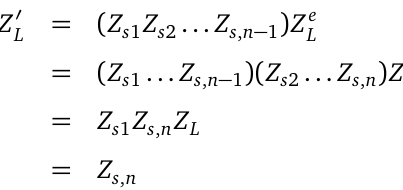
chain is a blue (light) L and Z , with the initial (pre-move) software- L L , Z i ... Z i . The Z stabilizers involved in s , n s 2 s 3